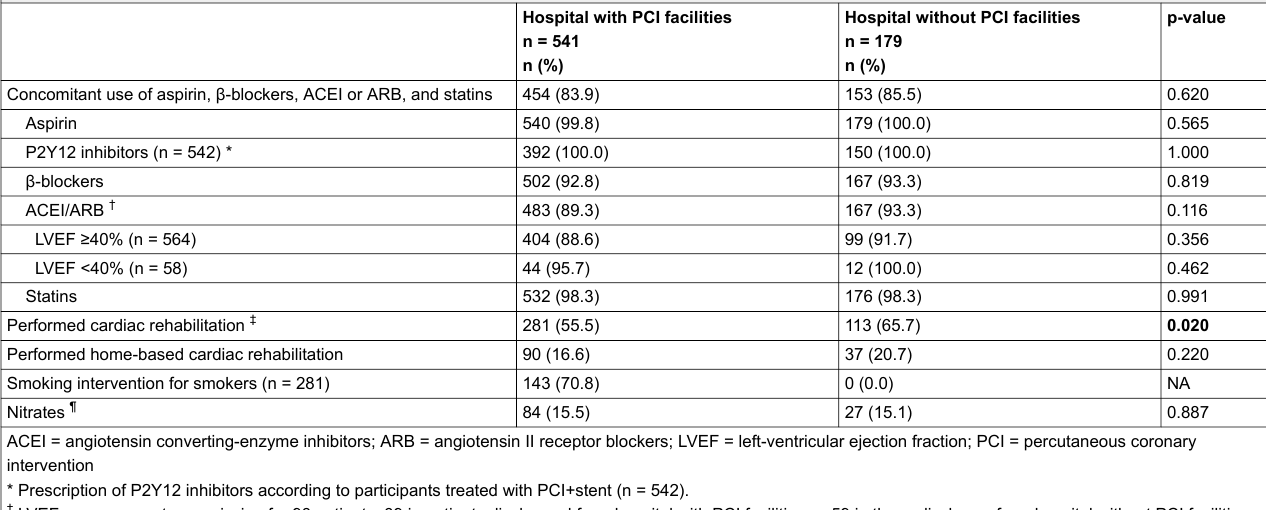
Table 2: Prescription rates of secondary prevention therapies at discharge, according to type of hospital (n = 720).